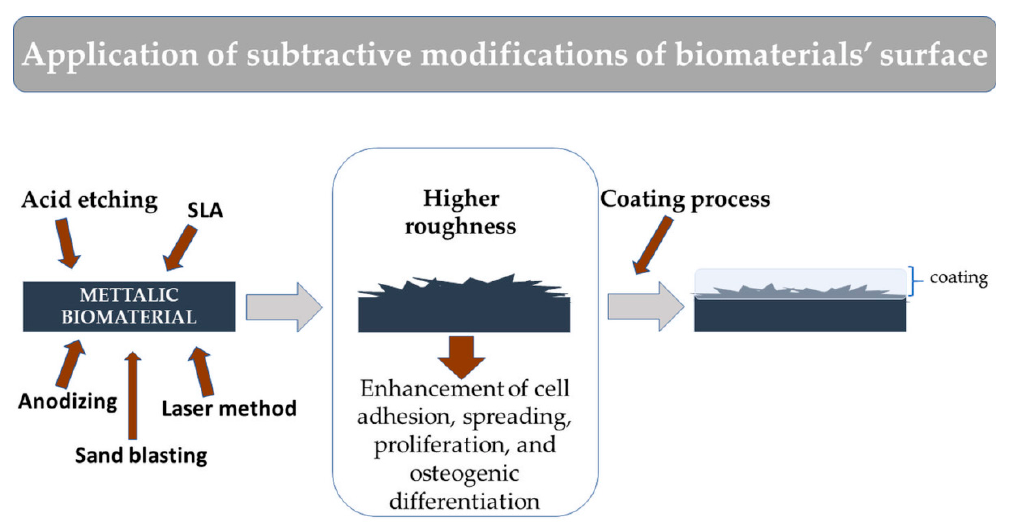
Figure 4. Scheme presenting application of subtractive modifications of biomaterial surface.